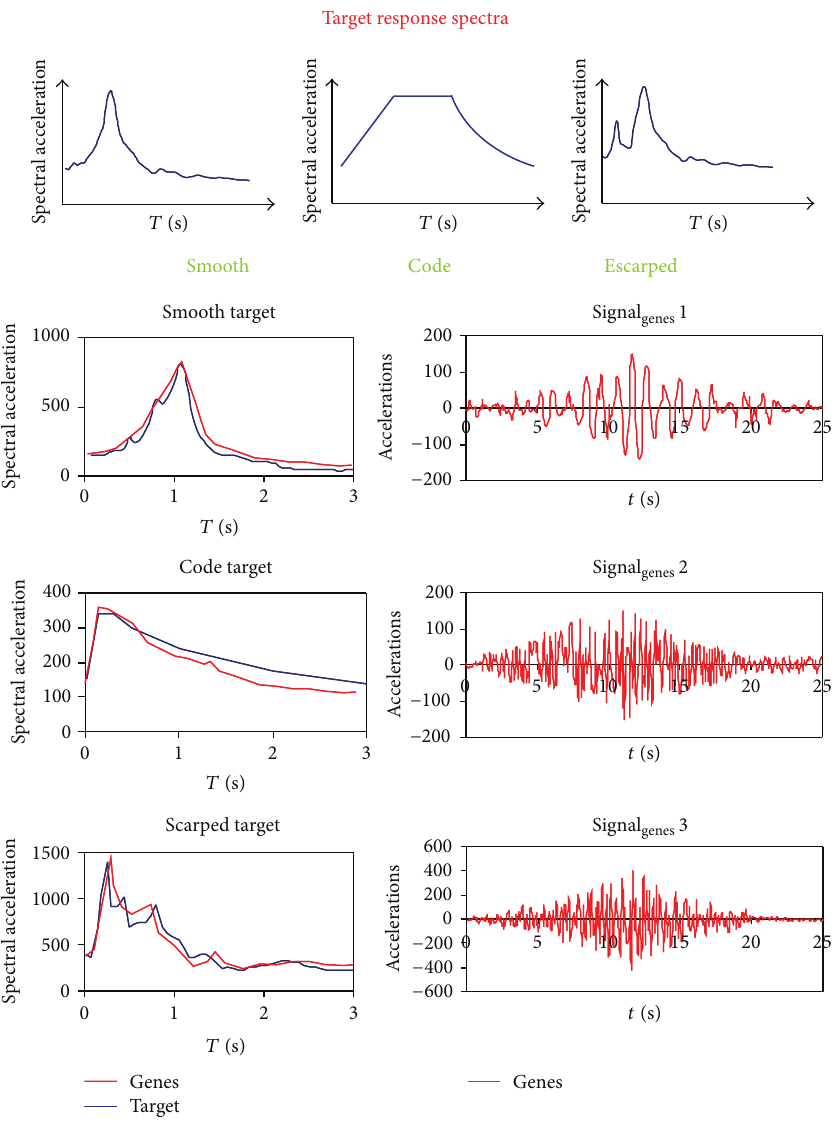
Figure 19: Some generator results: accelerograms